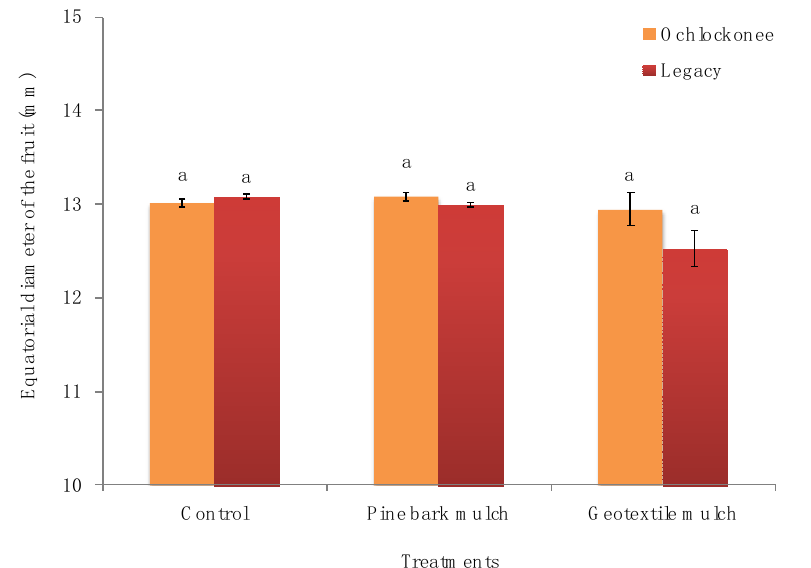
Figure 6. Effects of the different types of mulch on the equatorial diameter of the fruit. For each cultivar, different lowercase letters indicate significant differences for different types of mulch, according to the Tukey test ( p < 0.05). The vertical bars correspond to ± the standard error of the mean ( n =